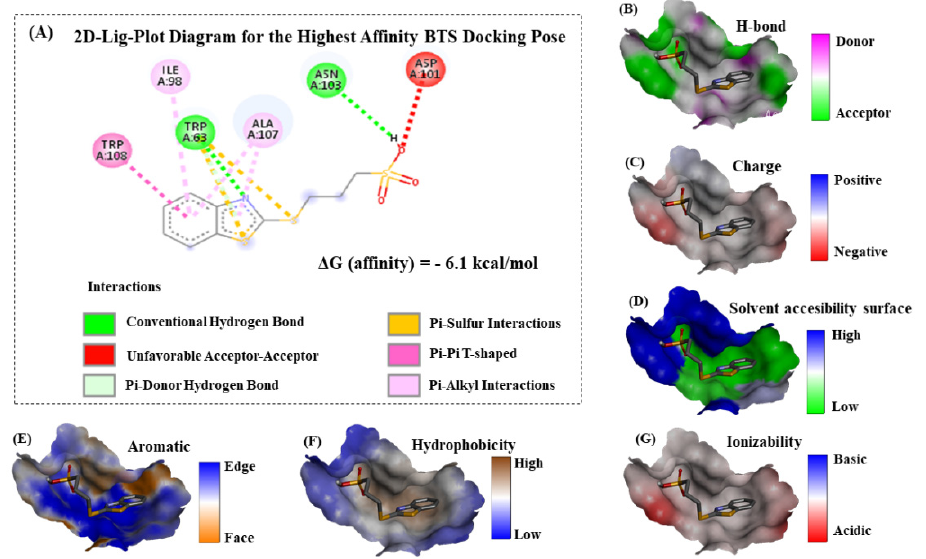
Figure 6. Inside the box, ( A ) represents the 2D-lig-plot diagram of interactions obtained for the best-ranked BTS docking pose with Δ G (docking affinity) = − 6.1 kcal/mol for the BTS-lysozyme complex. Herein, dotted-lines represent different types of interactions with the corresponding color-labels represented below. Outside the box, ( B – G ) represent a breakdown of the different binding contributions to the BTS-lysozyme complex stability in the biophysical environment of interaction (i.e., lysozyme binding site) as: H-bond, electrostatic charge, solvent accessibility surface, aromatic interactions, hydrophobicity, and ionizability, all represented as Van der Waals surfaces with the corresponding bar-color of intensity, on the far right.